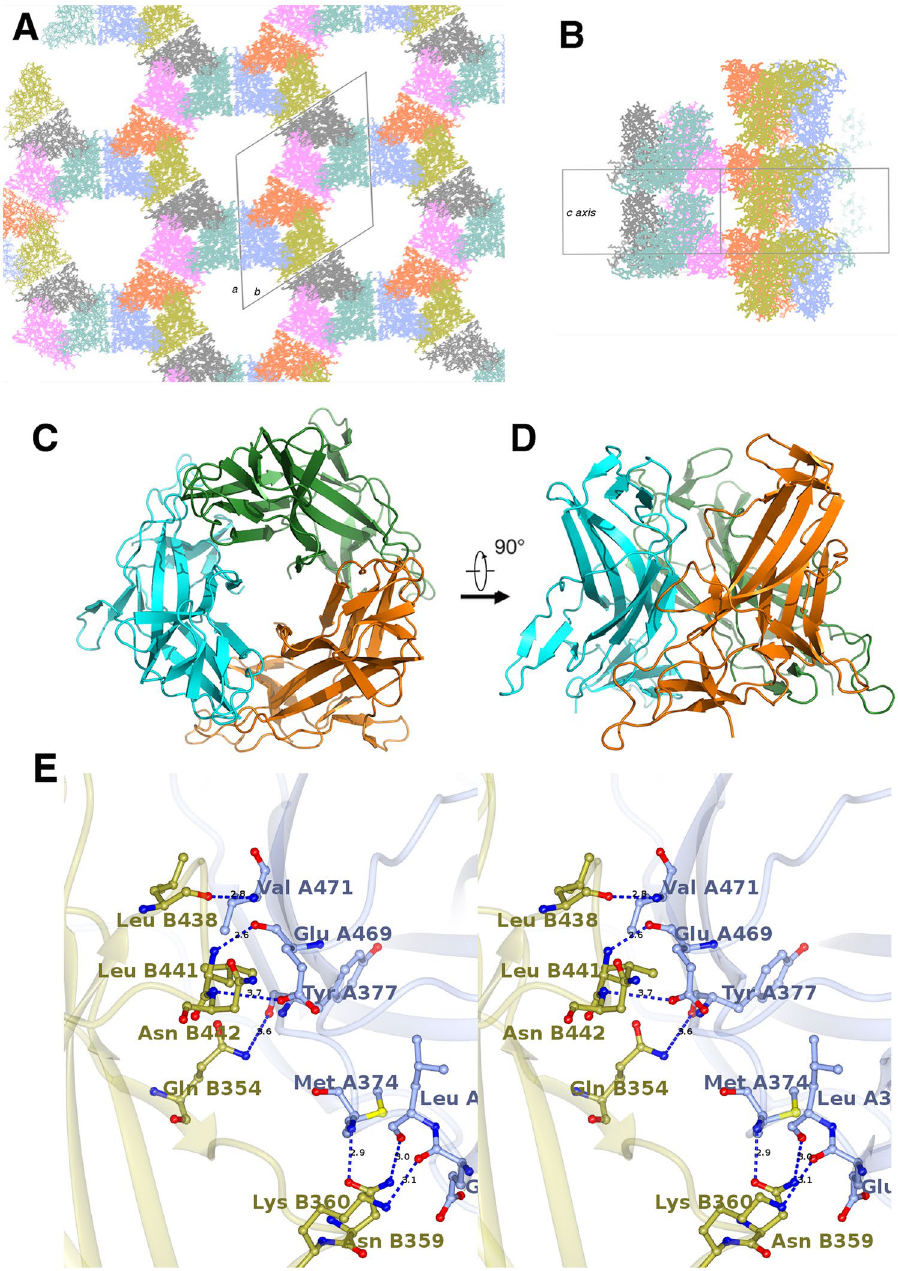
Figure 3. Oligomerization of MyRF DBD in crystal. ( A ) Crystal packing of MyRF DBD viewed from the c axis. Unit cell is shown in black lines. ( B ) Side view of crystal packing. ( C ) Cartoon diagram of MyRF DBD trimer (crystallographic symmetry-related protomers) ( D ) Side view of MyRF DBD trimer. ( E ) Stereo view of detailed trimeric interactions between 2 neighboring protomers. The residues involved in the hydrogen bond interactions are shown with a stick model; nitrogen and oxygen atoms are colored blue and red respectively. 2 neighboring protomers are illustrated and colored ice blue and gold